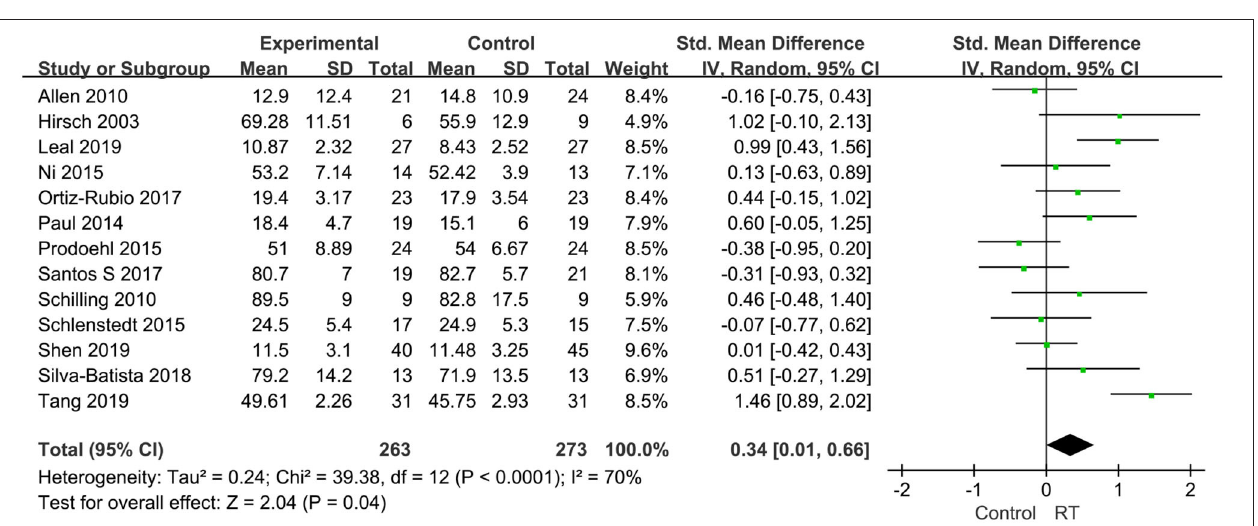
FIGURE 4 | Forest plots of the effects of lower limb RT on balance performance in PD. CI, confidence interval.